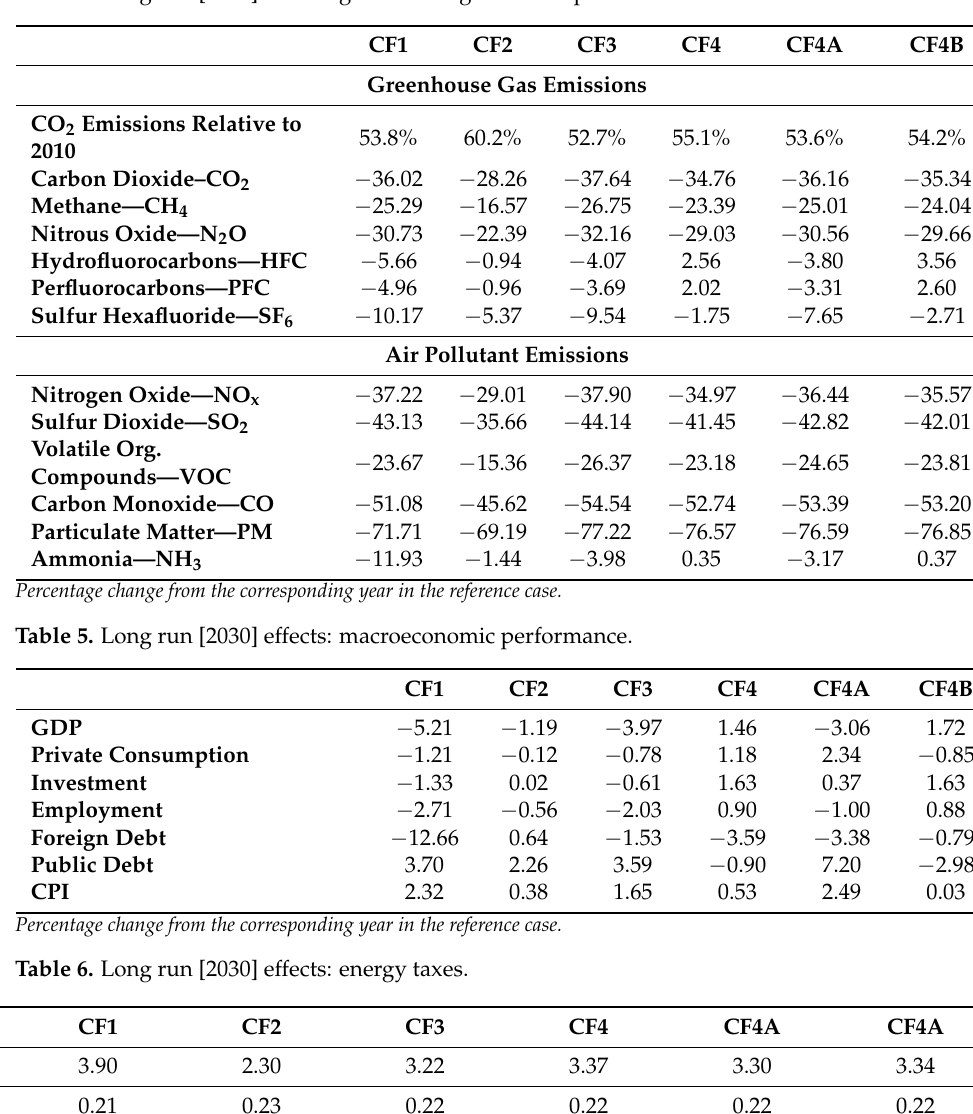
Table 4. Long run [2030] effects: greenhouse gas and air pollutant emissions.